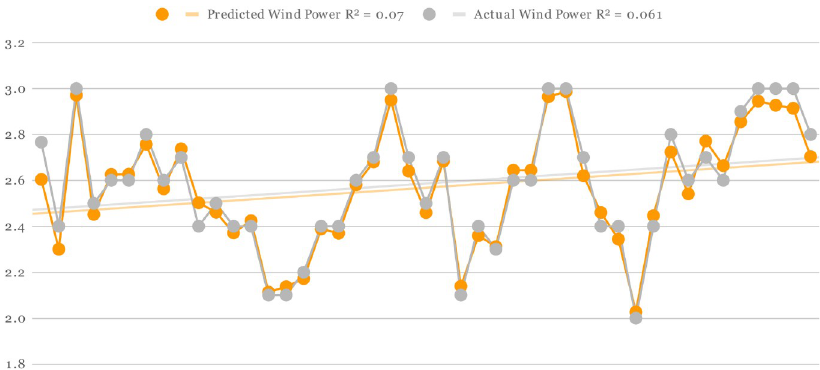
Fig 6. Predicted and actual power generation on Offshore Windfarm 2 based on Table 3 fine-tuned setting and proposed forecasting architecture.